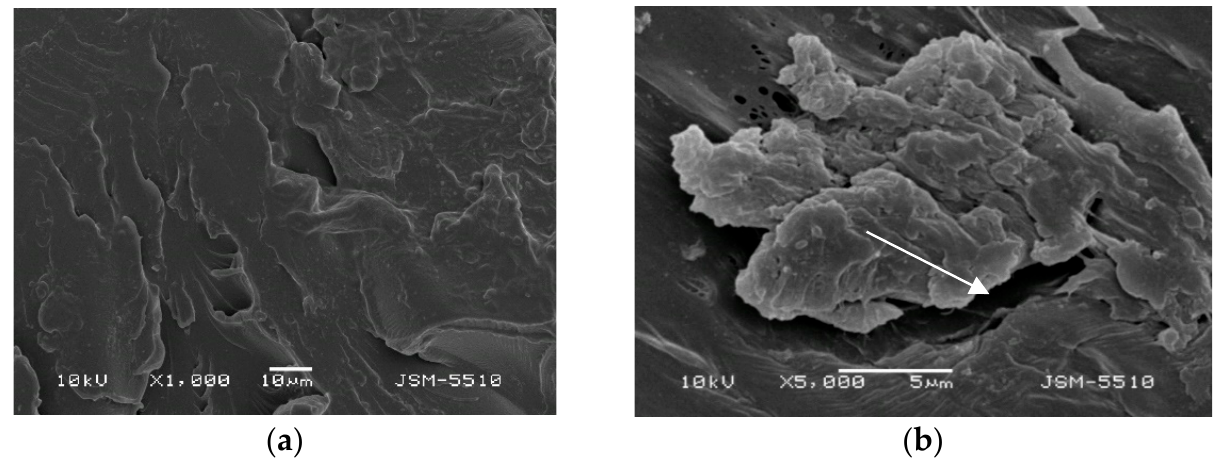
Figure 3. ( a ) BS under magnification ×1000. ( b ) BS under magnification ×5000.